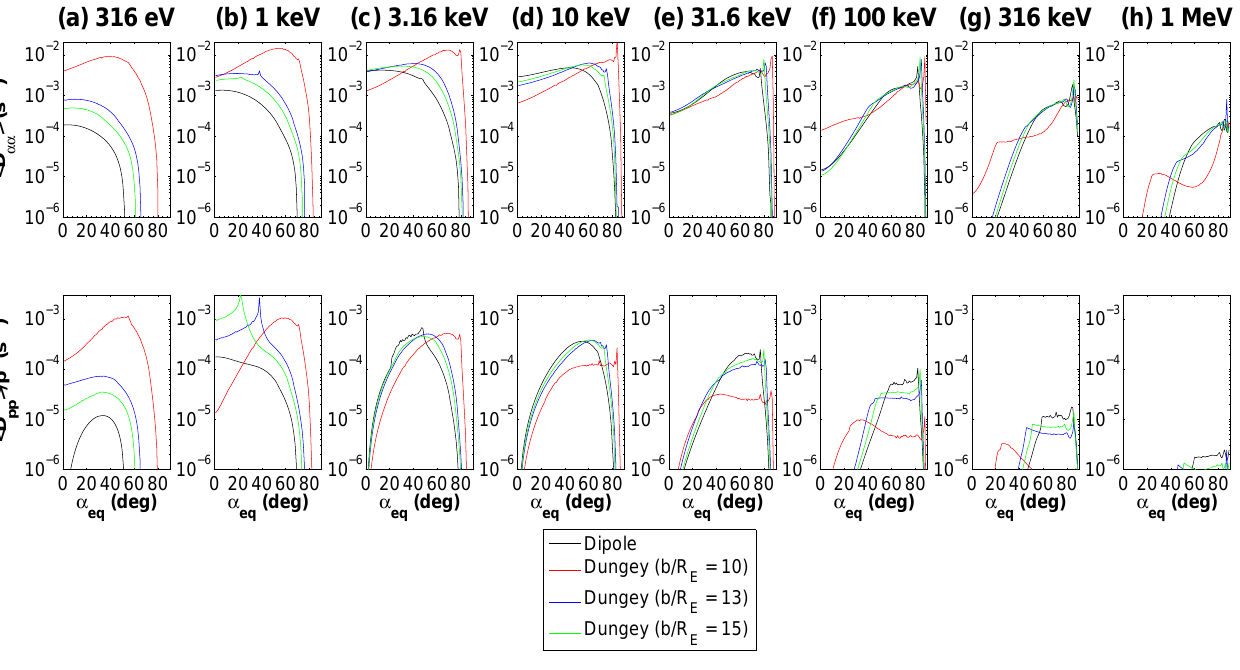
Fig. 7. Same as Fig. 5, expect for r 0 = 9 R E with b / R E = ∞ (dipole), 15, 13 and 10.